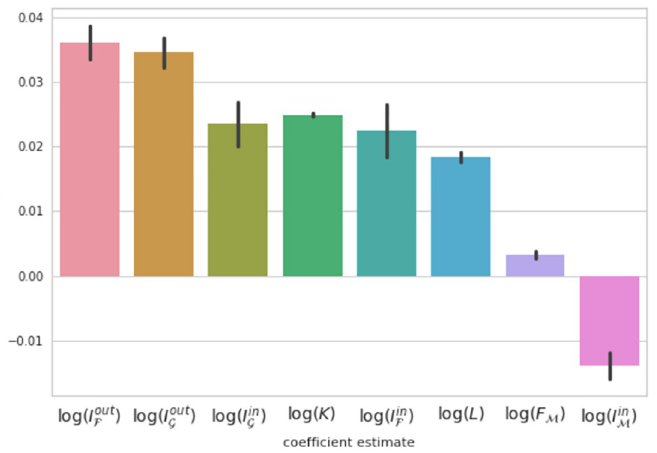
Fig 4. Coefficient estimates for model 4 leveraging an Elastic-Net regressor to reduce the multicollinearity effect. Bootstrap errors are shown in black, demonstrating significance of the effects. All social capital indicators have positive effects but out-information capital in the migration